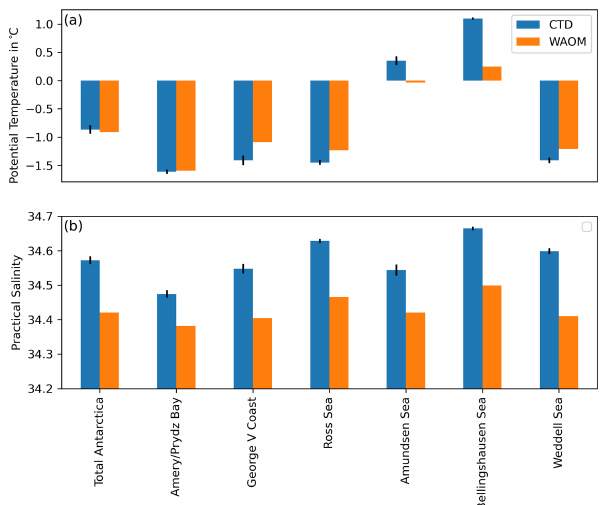
Figure 10. Sector-wise mean of on-shelf bottom layer hydrogra- phy from WAOM and observations. (a) Potential temperature and (b) practical salinity. As Fig. 9, but area-averaged over individual Antarctic sectors. CTD data also show the sector mean of the stan- dard deviations provided by Schmidtko et al. (2014). Regions with sparse observations have been excluded from the analysis (western East Antarctica and Sabrina Coast; see Fig. 1 for sector